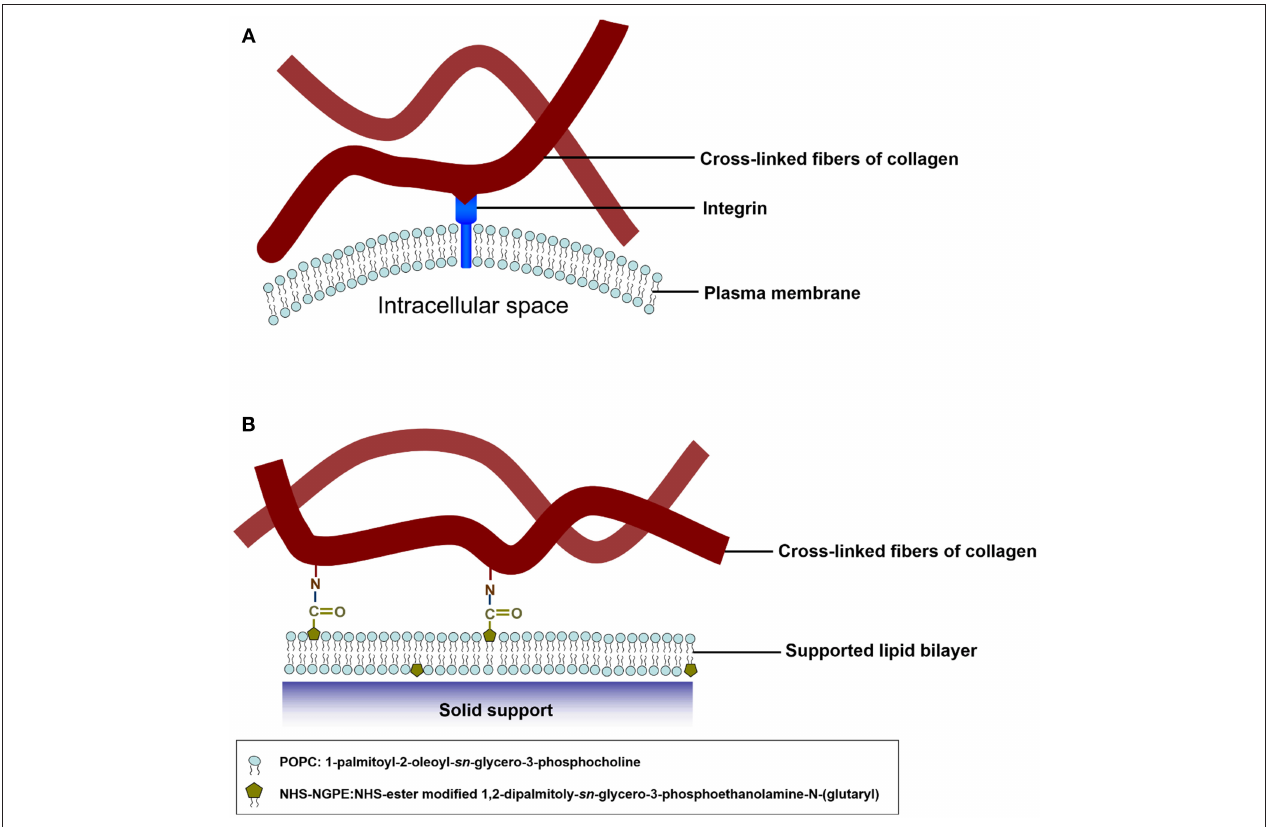
FIGURE 1 | Schematic illustration of mimetic collagen modification strategy based on integrins in mammalian cells. (A) In the in vivo microenvironment of cells, they attach collagen fibers via integrins. (B) To mimic the microenvironment of the cells, collagen fibers are chemically modified onto the model SLB. The blue spheres symbolize POPC headgroups and the olive pentagons represent the NHS-ester groups of DP-NGPE. Reprinted with permission from Huang et al. (2010b). Copyright 2010 American Chemical Society.